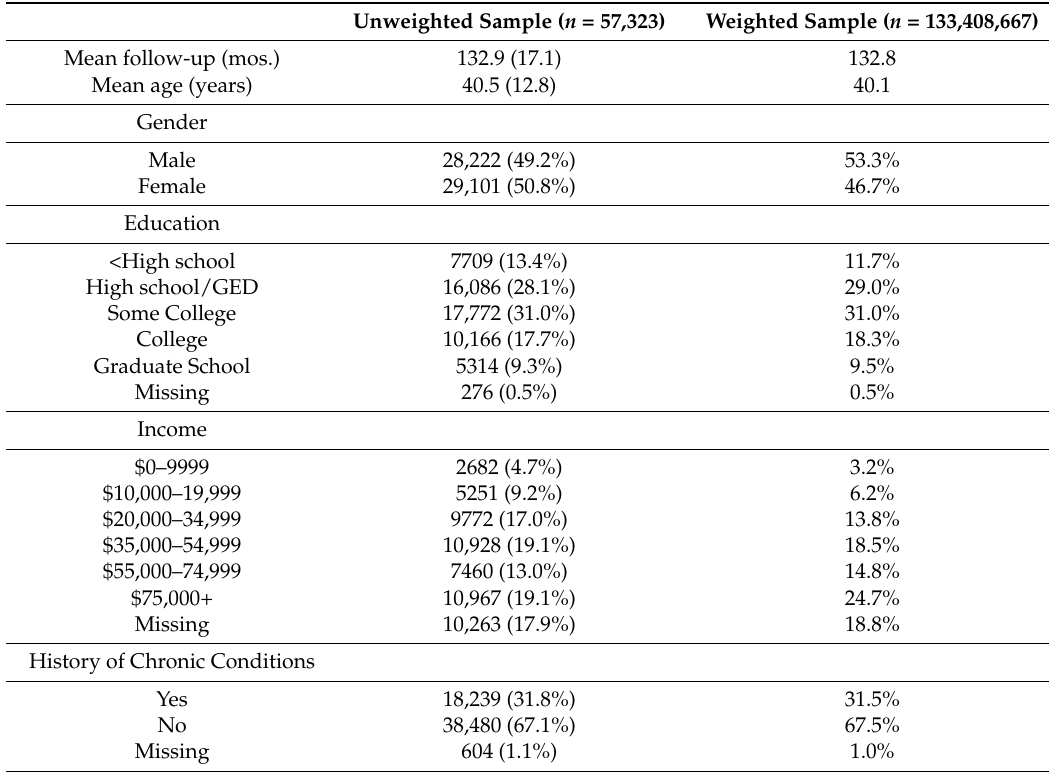
Table 1. Descriptive characteristics of unweighted and weighted analytic samples, USA National Health Interview Surveys 2000–2002.